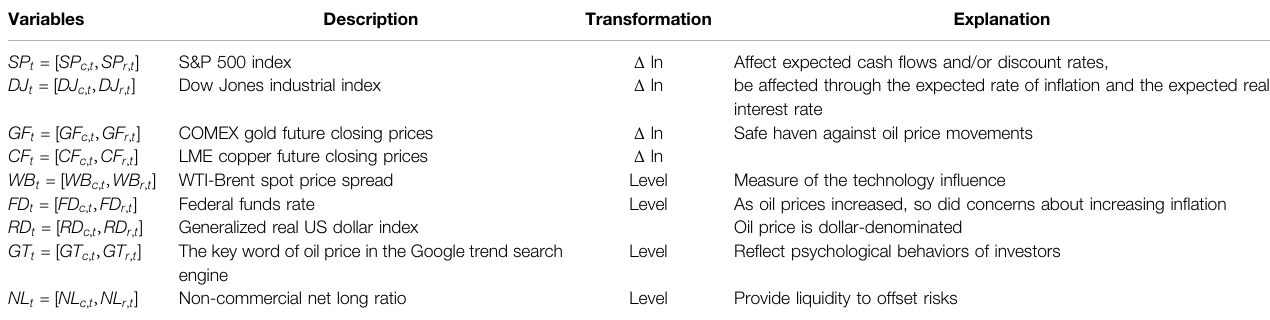
The key word of oil price in the Google trend search engine